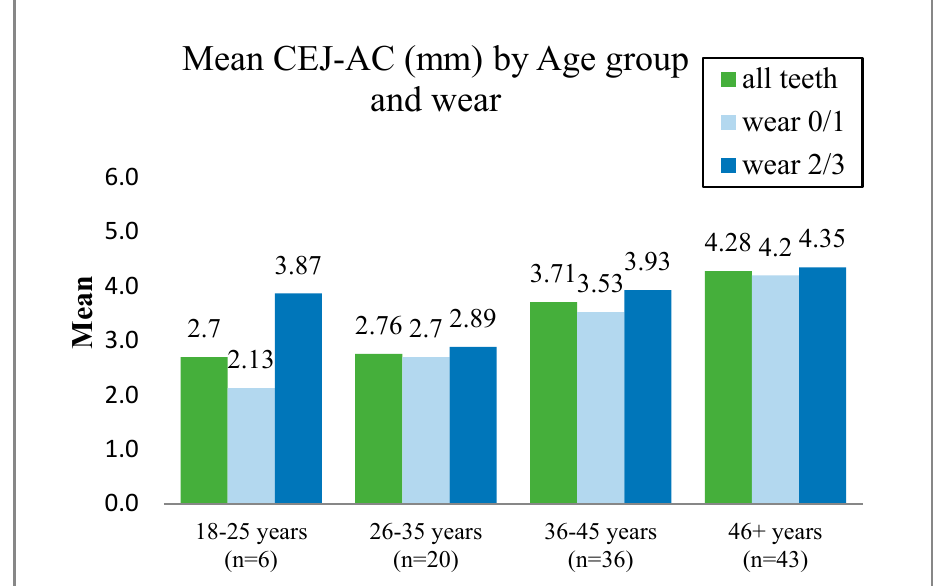
Figure 2. Mean CEJ – AC (mm) by tooth wear (mean CEJ-AC distance by age group for all teeth, teeth Figure 2. Mean CEJ–AC (mm) by tooth wear (mean CEJ-AC distance by age group for all teeth, teeth with wear 0/1, and teeth with wear 2/3). with wear 0/1, and teeth with wear 2/3).